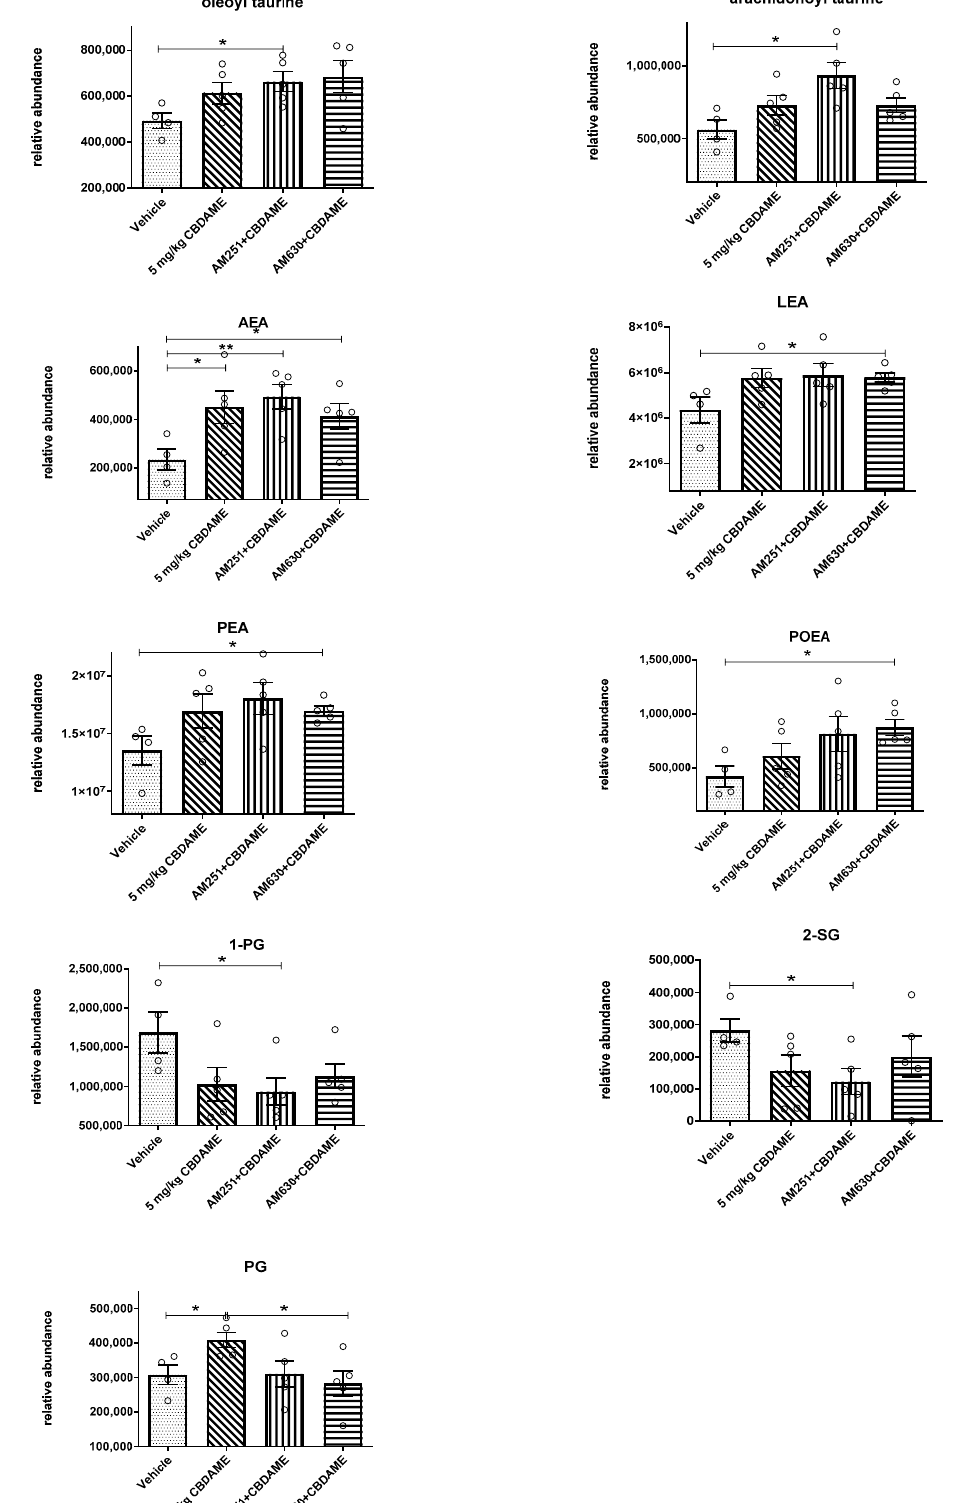
Figure 7. Selected endocannabinoids blood level (mean + SEM) of female WKY rats. Rats received either vehicle (n = 4) or 5 mg/kg CBDA-ME (n = 5), 1 mg/kg AM251 + 5 mg/kg CBDA-ME (n = 5), 1 mg/kg AM630 + 5 mg/kg CBDA-ME (n = 5). * p < 0.05; ** p <